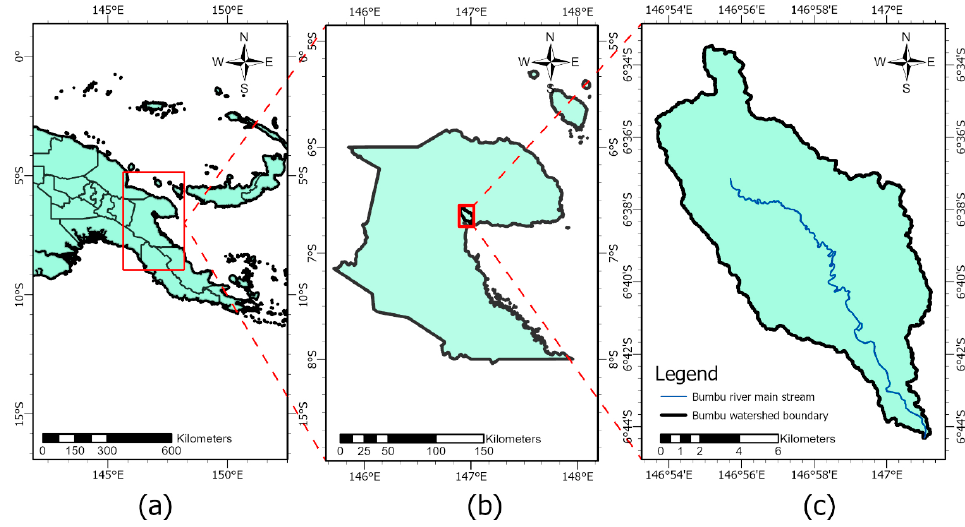
Figure 1. The study area: ( a ) Papua New Guinea, ( b ) Morobe Province, ( c ) Bumbu river basin.